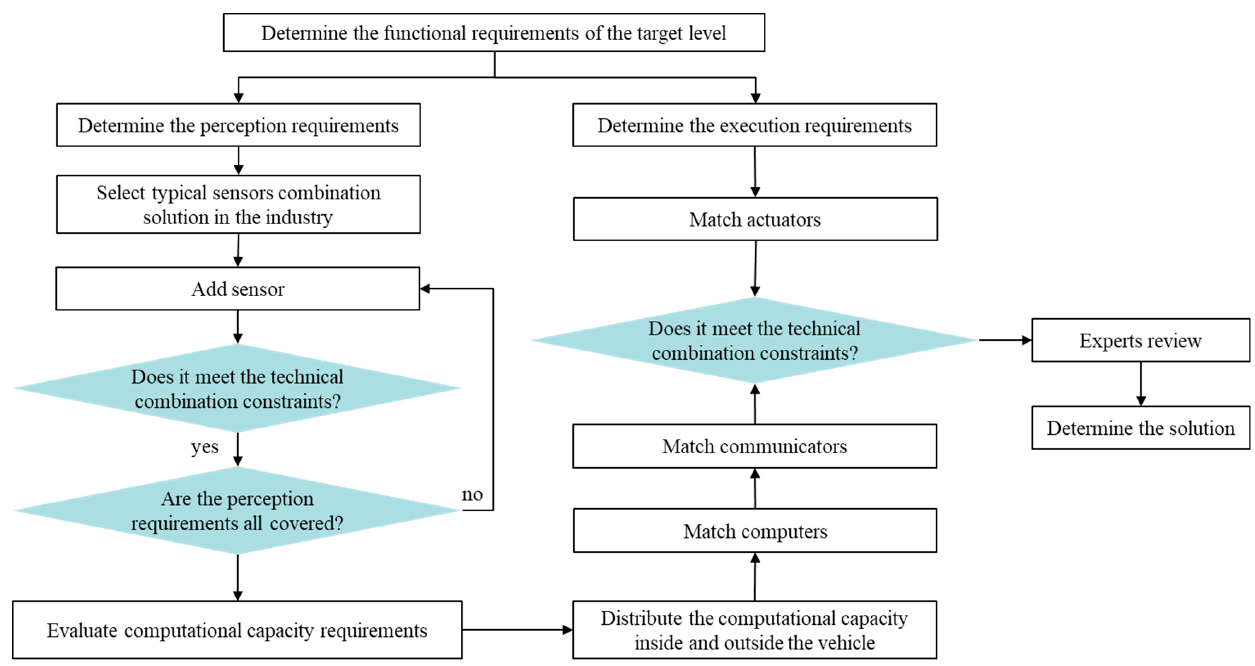
Figure 2. Combination process of the technical components of intelligent driving.